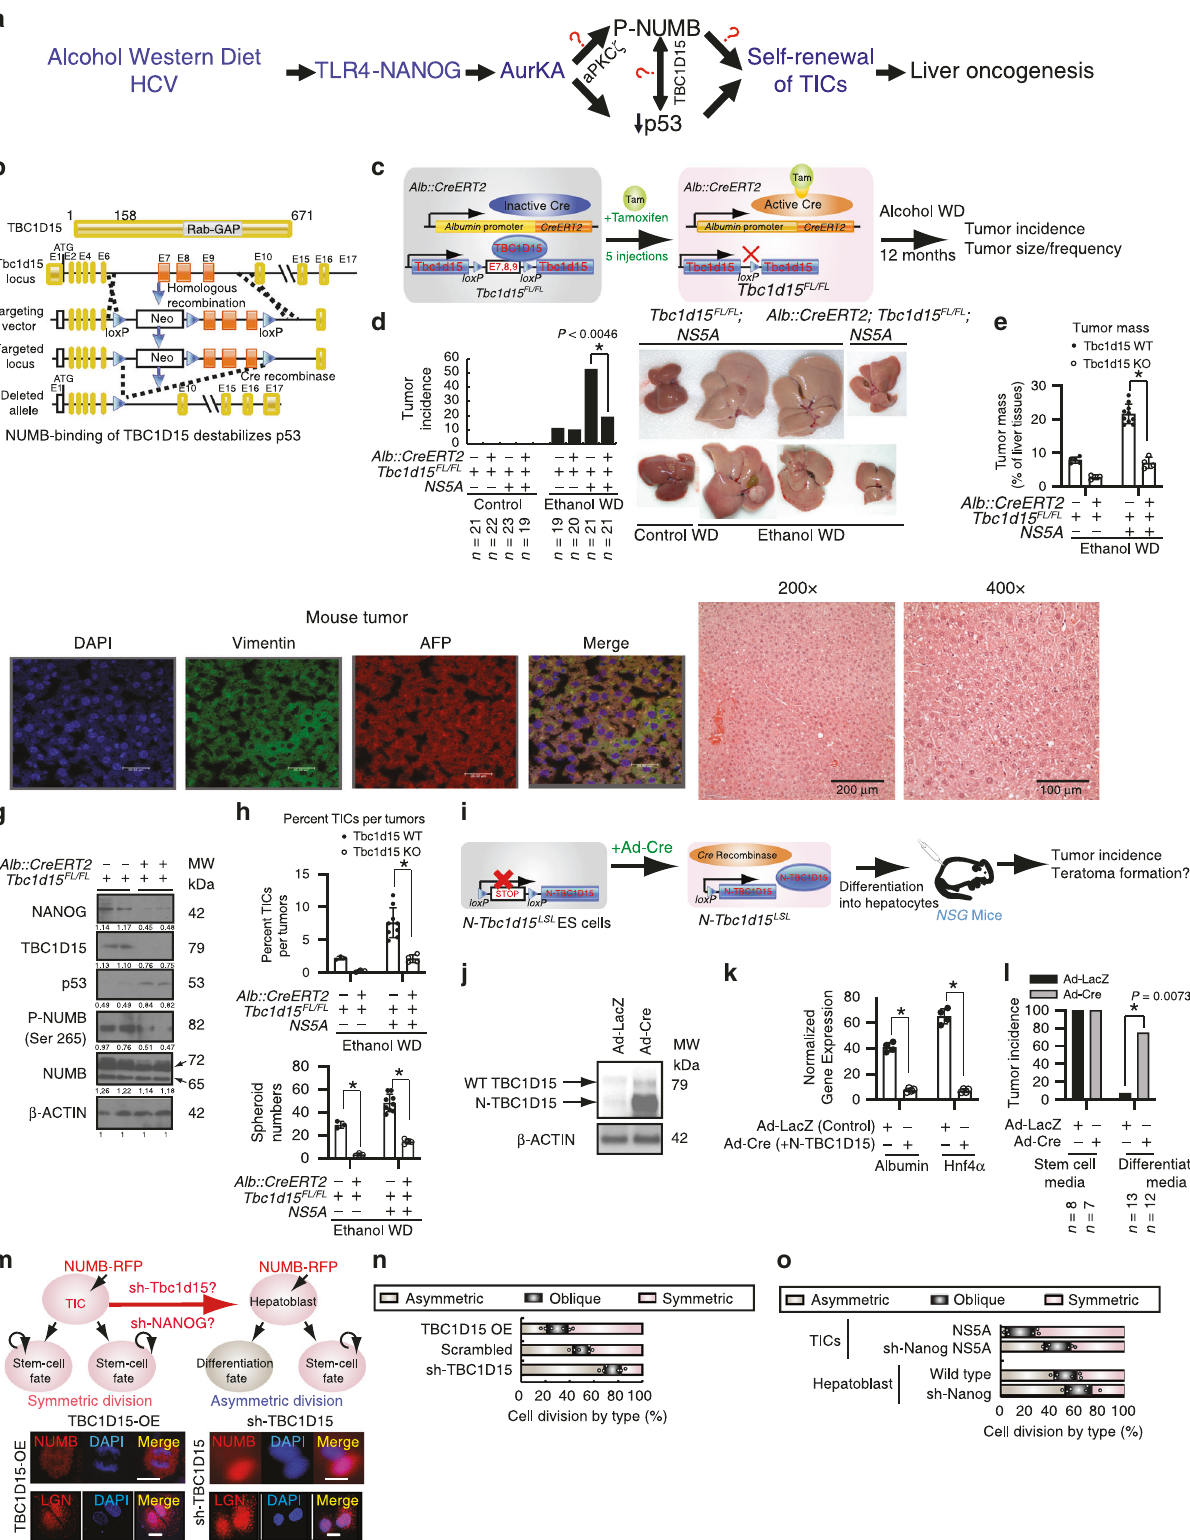
(Fig. 1n). Nanog KD reduced the percentage of TICs undergoing symmetrical division approaching that observed in mouse hepatoblasts (Fig. 1o). These results validated the pivotal role of TBC1D15 in TIC symmetric cell division.